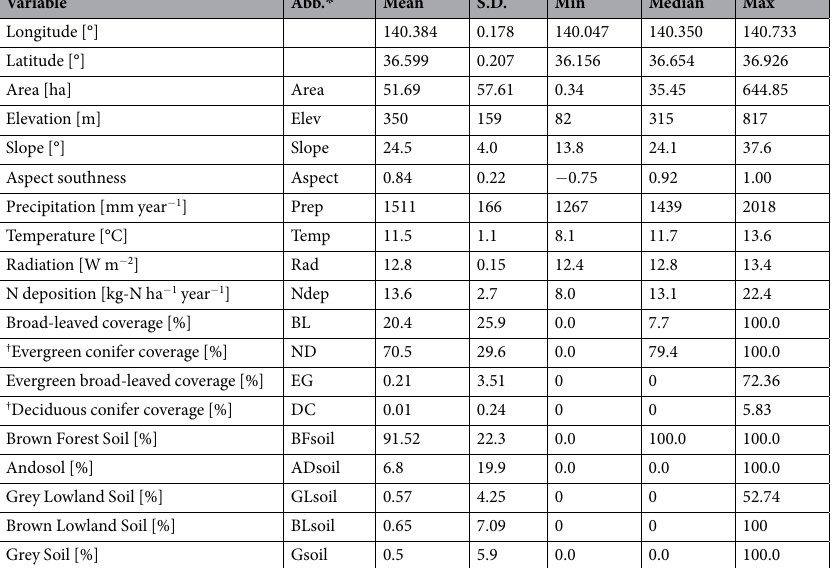
Table 2. Statistical summary of sampled catchment (N = 608). * Indicates abbreviations in the results of random forest model (Fig. 3). S.D. indicates standard deviation. Forest coverages with † indicate afforested forests (i.e., plantation).